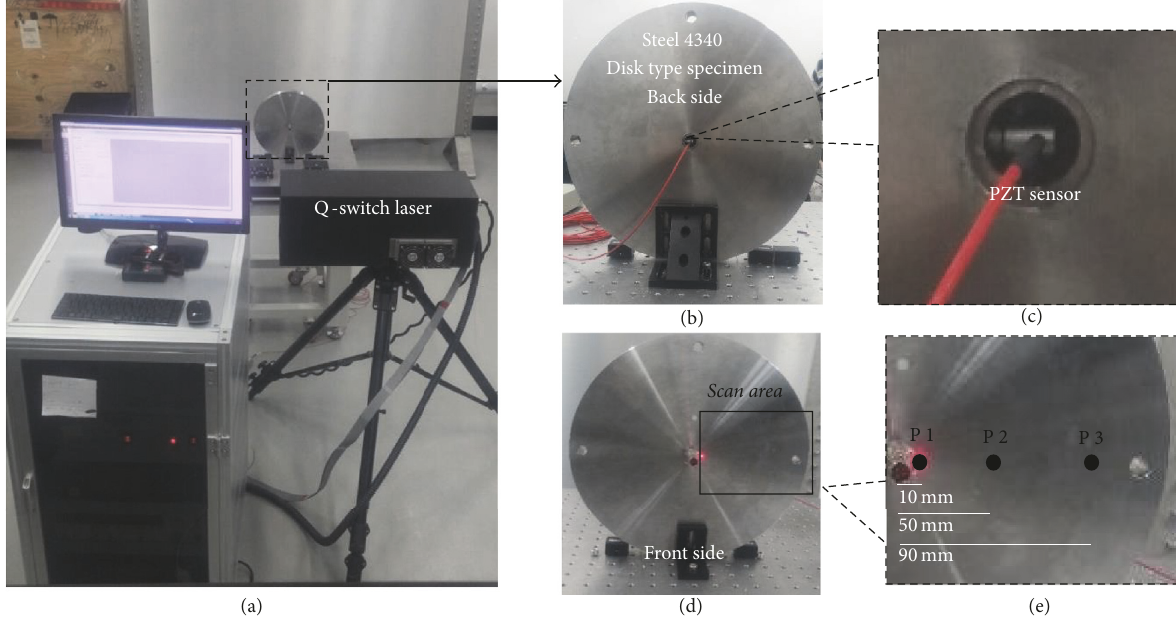
Figure 22: Scanning measurement system of laser shock for reconstruction of explosive induced pyroshock on the disk type